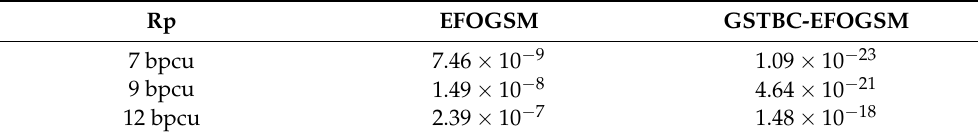
Figure 5. ABER comparison between GSTBC-EFOGSM and EFOGSM schemes under different data transmission rates R ‘ . P Table 3. Table of ABER performance comparison between EFOGSM and GSTBC-EFOGSM with SNR =